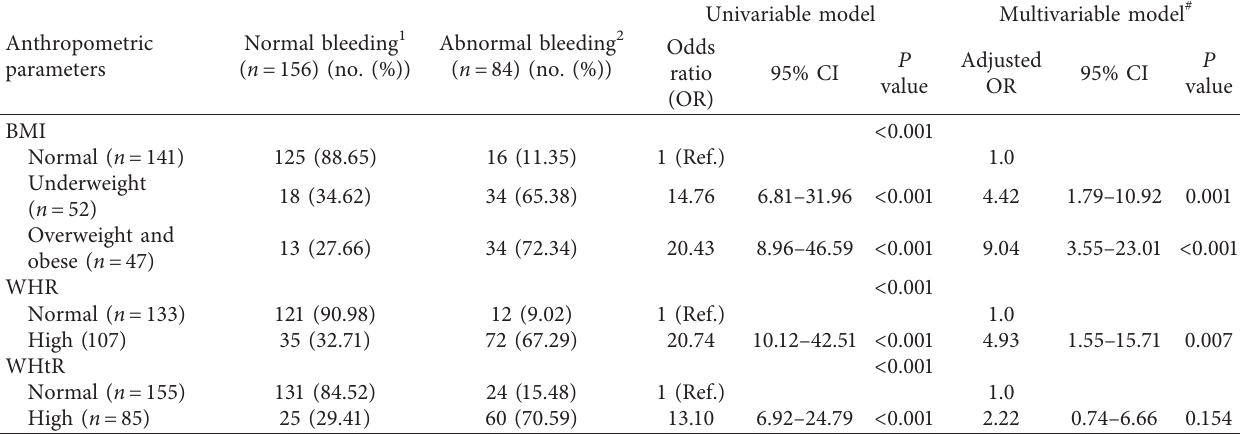
Table 5: Association of anthropometric parameters with periodic menstrual blood loss (defined by no. of menstrual pads/cycle) by using binary logistic regression